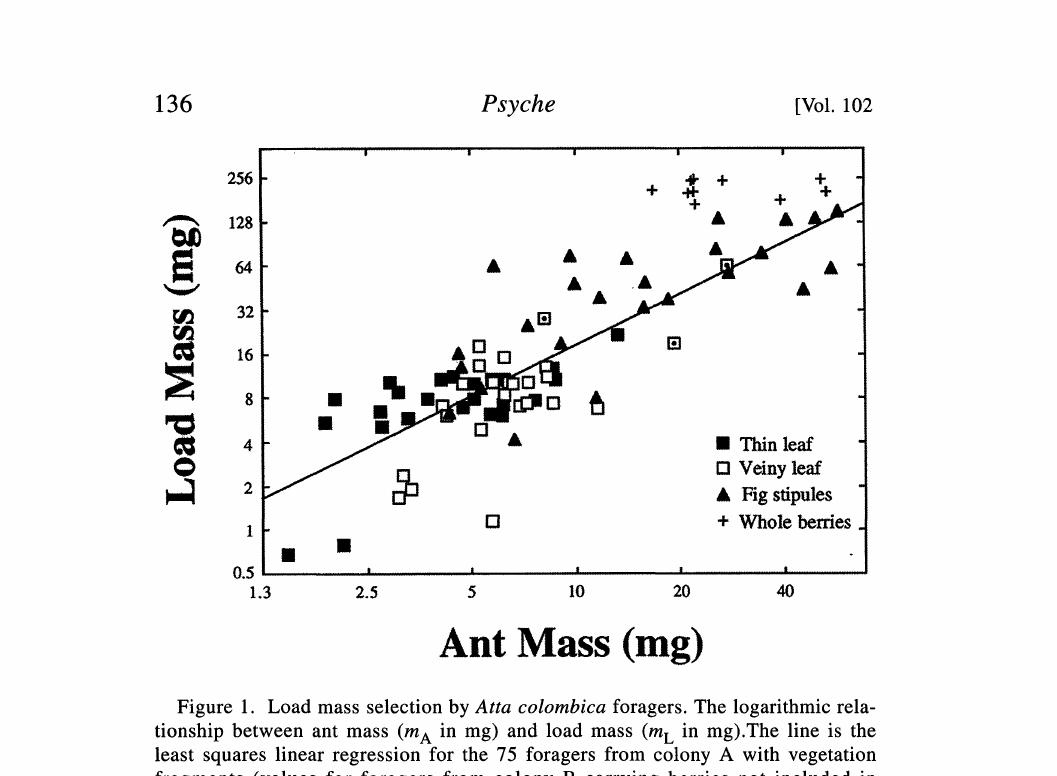
Figure 1. Load mass selection by Atta colombica foragers. The logarithmic rela- tionship between ant mass (m A in mg) and load mass (m E in mg).The line is the least squares linear regression for the 75 foragers from colony A with vegetation fragments (values for foragers from colony B carrying berries not included in regression calculation). Equation given in text. Closed squares thin leaf tree; open squares veiny leaf tree (with dot leaf stipule); closed triangles fig stipules; crosses whole berries. Table 2. Load size for Atta colombica foragers from colony A at three different vegetation sources (thin leaf, veiny leaf, and fig stipule). Burden ( mL/mA), residual log load mass (log mL), and residual log load area (log a). For each col- lection, n 25.